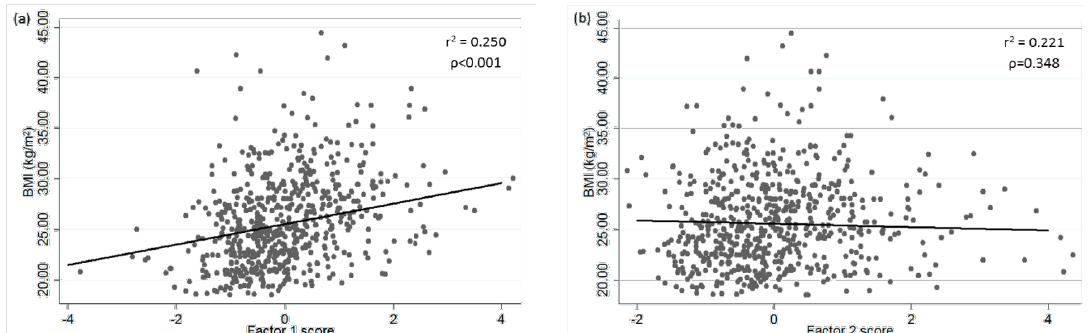
Figure 2. ( a ) Regression representation of BMI for Factor 1 adjusted for age, gender, energy intake, physical activity, supplement user, and smoking habit; ( b ) Regression representation of BMI for Factor 2 adjusted for age, gender, energy intake, physical activity, smoking habit, and supplement user.